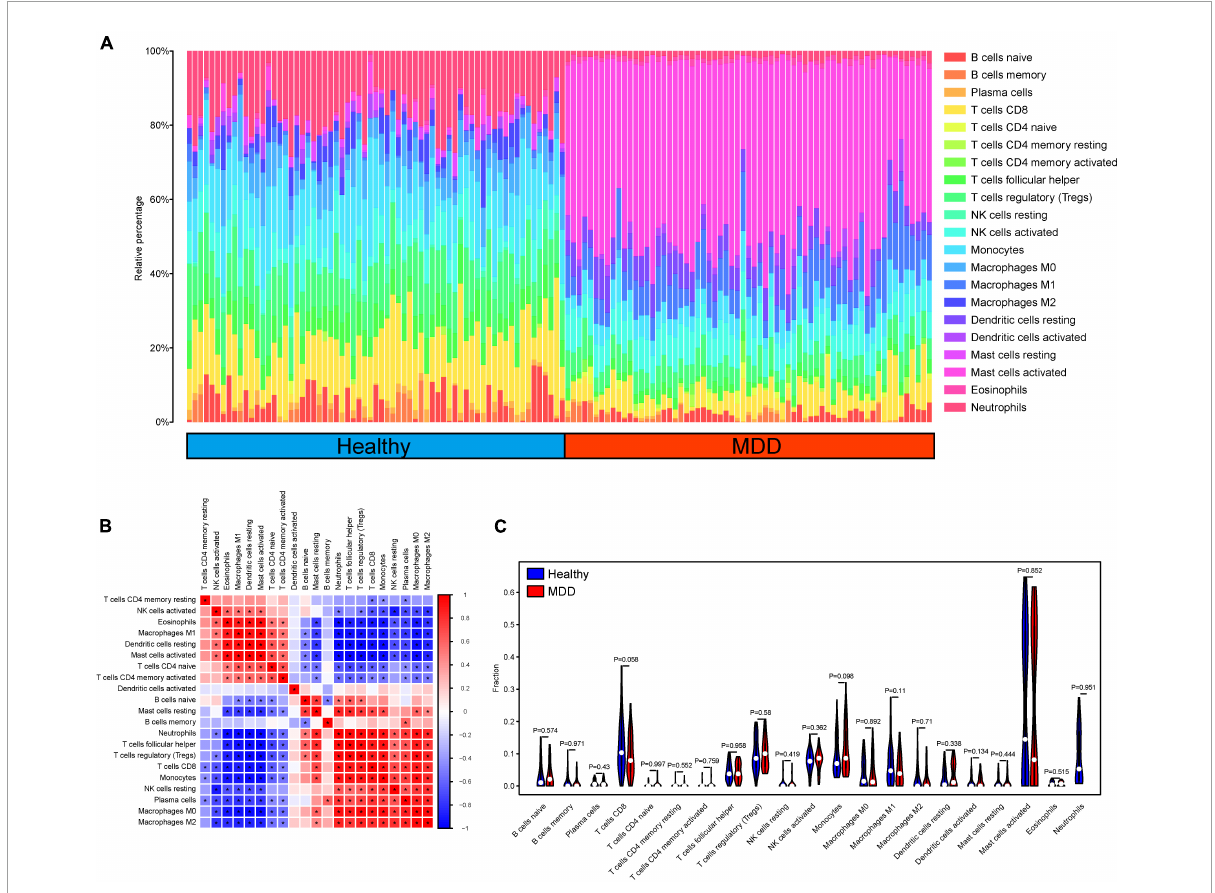
FIGURE6 Evaluation and correlation analysis of immune cell infiltration. (A) Panoramic view of 22 immune cell infiltrates in peripheral blood samples; (B, C) High and low expression group of immune cell infiltration